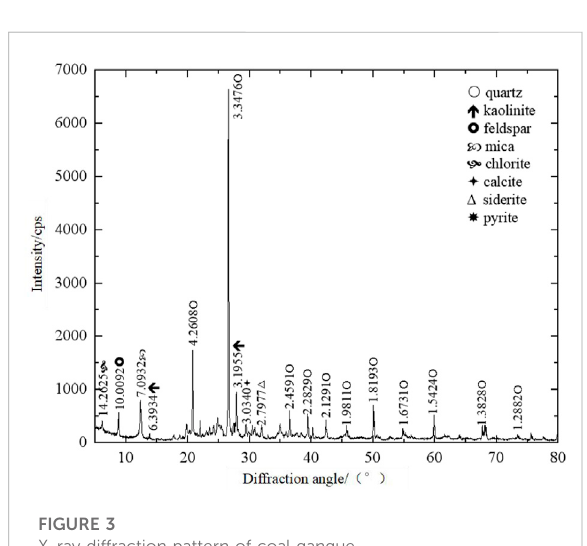
FIGURE 2 Particle size distribution curve of the gangue sample.